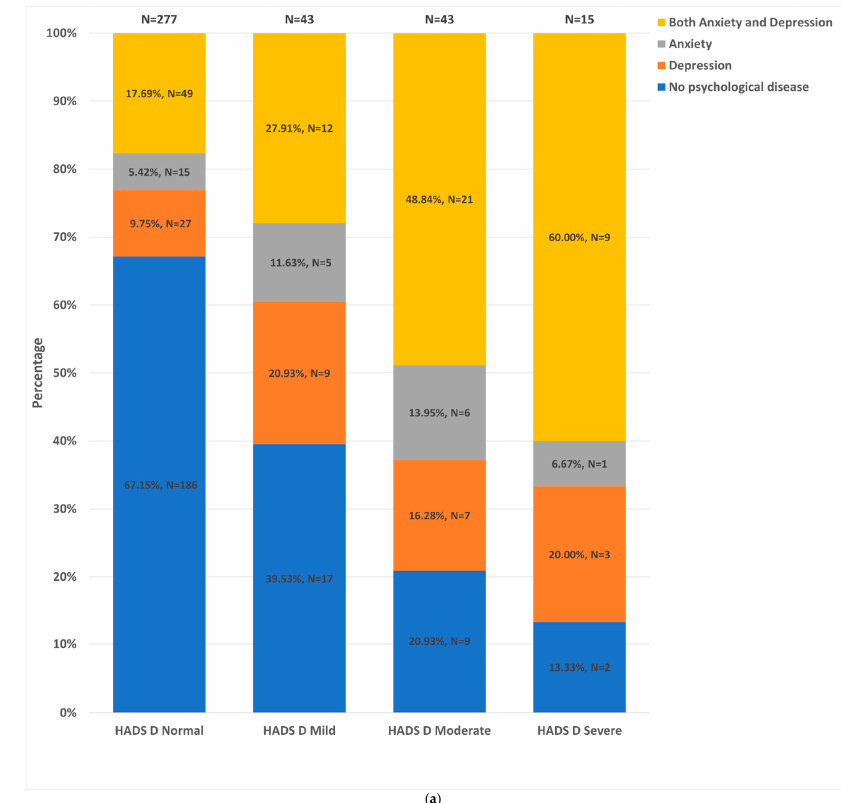
Figure 1. Summary clinical and phenotypical characteristics of WATCH subjects with psychological comorbidities, characterised against controls. ACQ6, Asthma Control Questionnaire 6; BMI, body mass index; HADS-A, Hospital Anxiety and Depression Scale Anxiety score; HADS-D, Hospital Anxiety and Depression Scale Depression score; SGRQ, St. George’s Respiratory Questionnaire; J. Pers. Med. 2022 , 12 , x FOR PEER REVIEW FeNO; fractional exhaled nitric oxide; OSA, obstructive sleep apnoea.